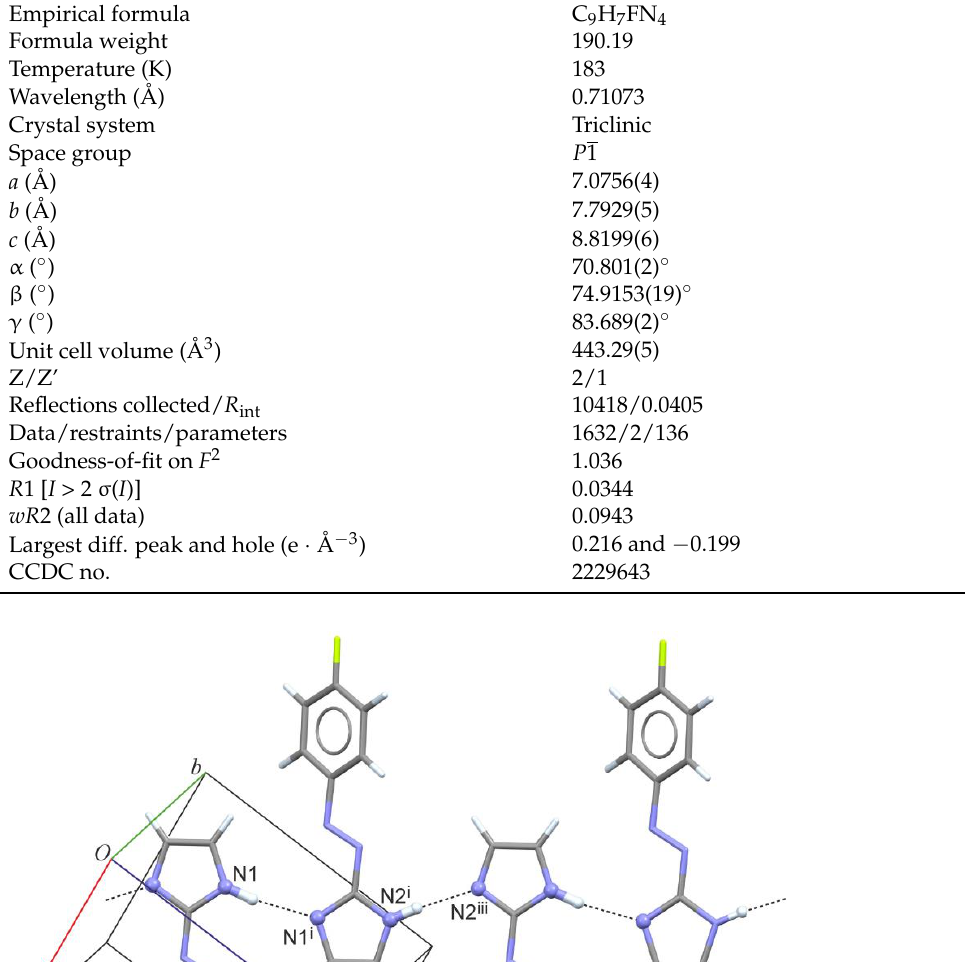
Table 1. Crystal data and structure refinement.